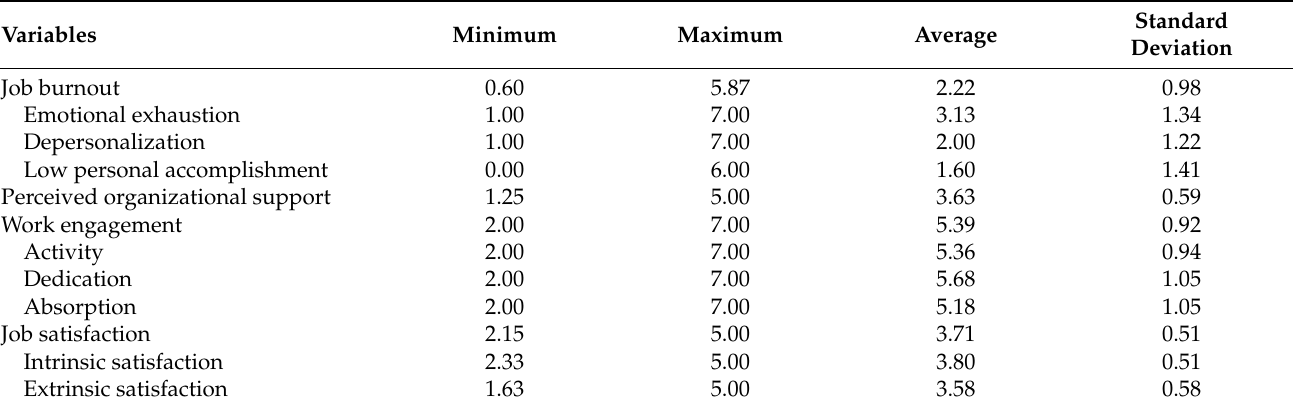
Table 2. Minimum, maximum, mean, and standard deviation of variables and